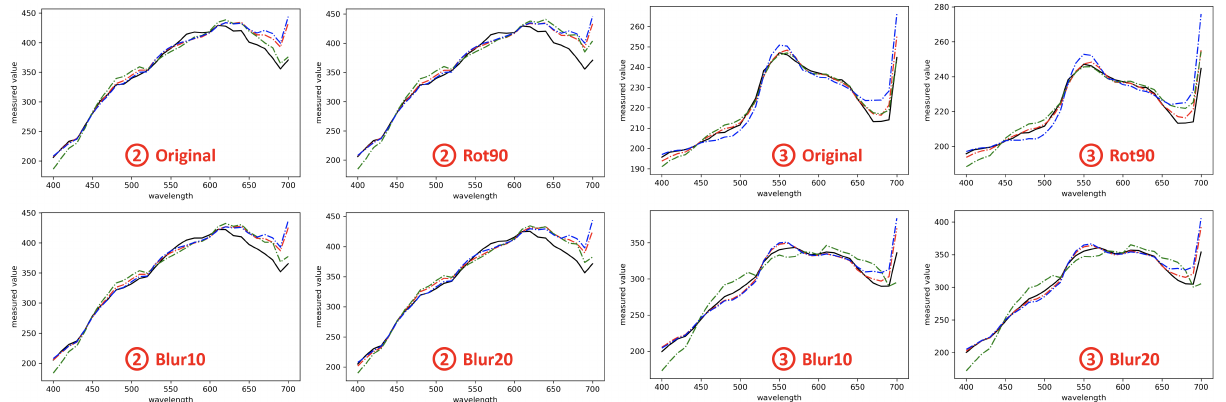
Figure 6. Visualization of the ground-truth and recovered spectra in region 2 (cid:13) and 3 (cid:13) in the example scene in Figure 5. The legend for the different colored curves is the same as in Figure 5: ground-truth (gt) is shown in black, A++ in red, AWAN in green, and HSCNN-D in blue. Respectively, region 2 (cid:13) refers to the “building” and region 3 (cid:13) the “plants”.